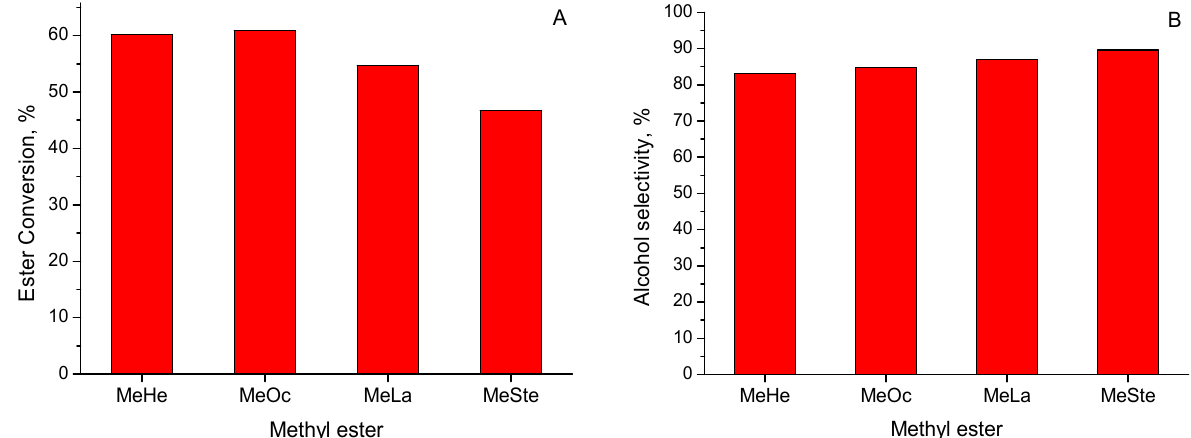
Figure 10. ( A ) Catalytic performance of 1CuZn catalyst in the hydrogenolysis of methyl esters varied in the length of a carbon chain. ( B ) Alcohol selectivity at ester conversion of ≈ 45%. T = 210 °C, p H2 = 100 bar, reaction time—3 h, catalyst weight—1.5 g, ester load—0.69 mol (in case of experiment with Me-Ste catalyst weight was reduced to 0.5 g, while 0.23 mol of the ester was dissolved in decalin), T reac. = 210 °C, p H2 = 100 bar.